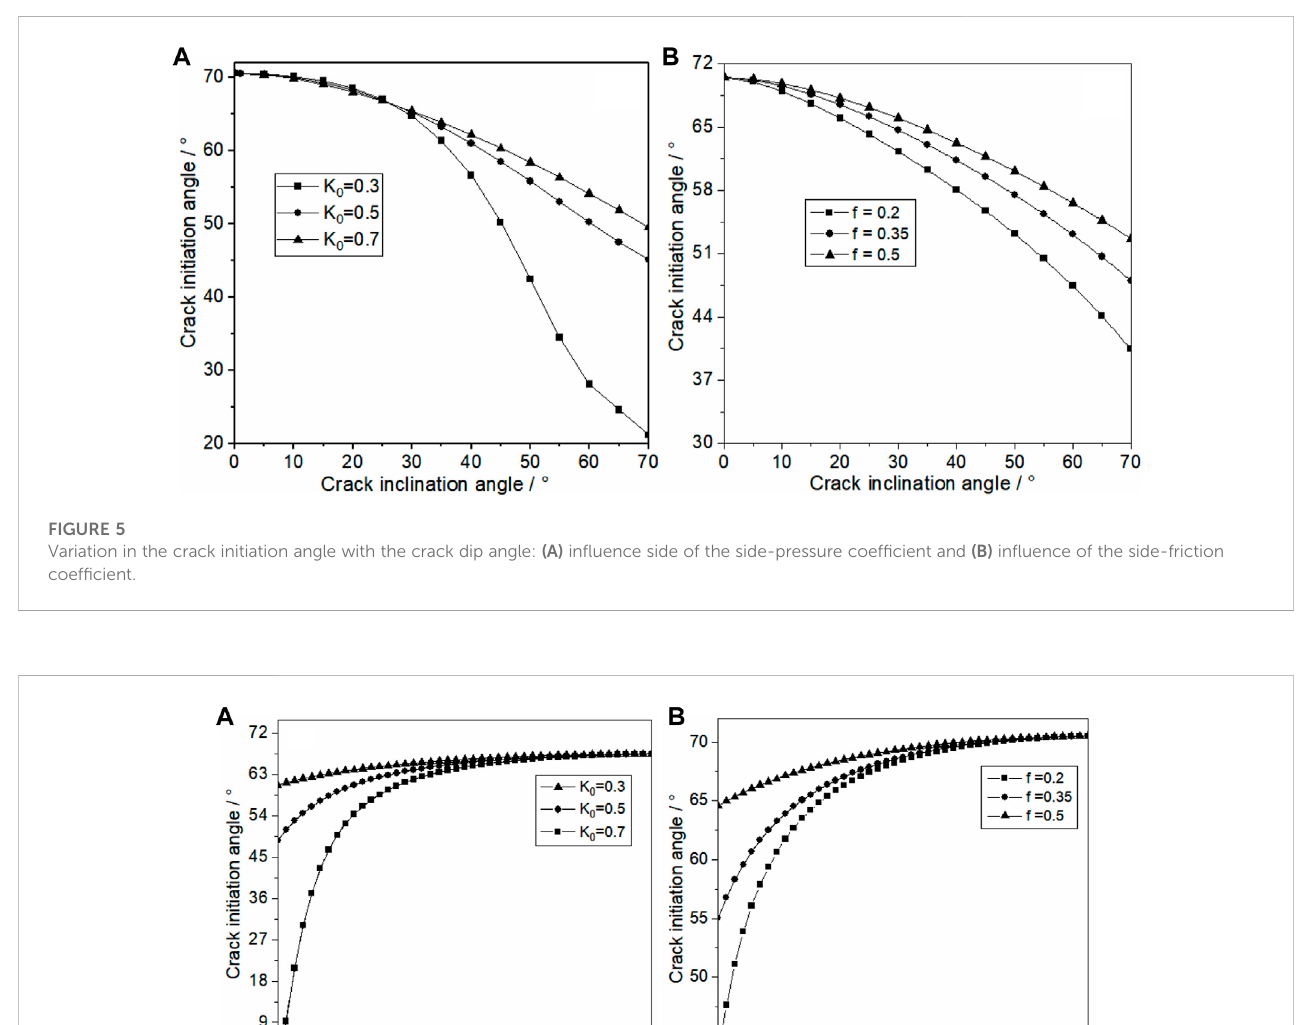
Figure 5. When the slope excavation unloads, the horizontal stress is instantly released; at this time, the crack propagation is mainly affected by the vertical stress; under the action of vertical stress, the initiation angle decreases with the increase in the crack inclination and gradually tends to the crack direction.